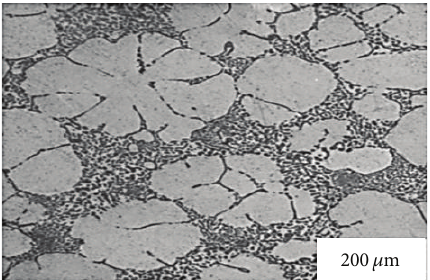
Figure 5: Microstructure of Sn-15% Pb alloy billets obtained by mechanical stirring